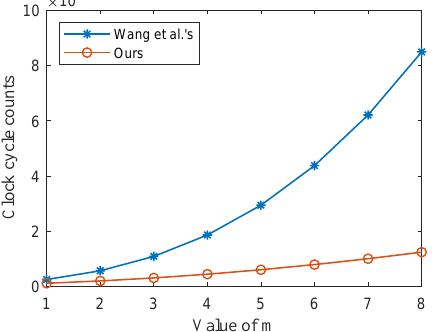
Figure 10: Comparison of the number of clock cycles with increasing m and fixed k = 1 for the original masked implementation and our improved ones.